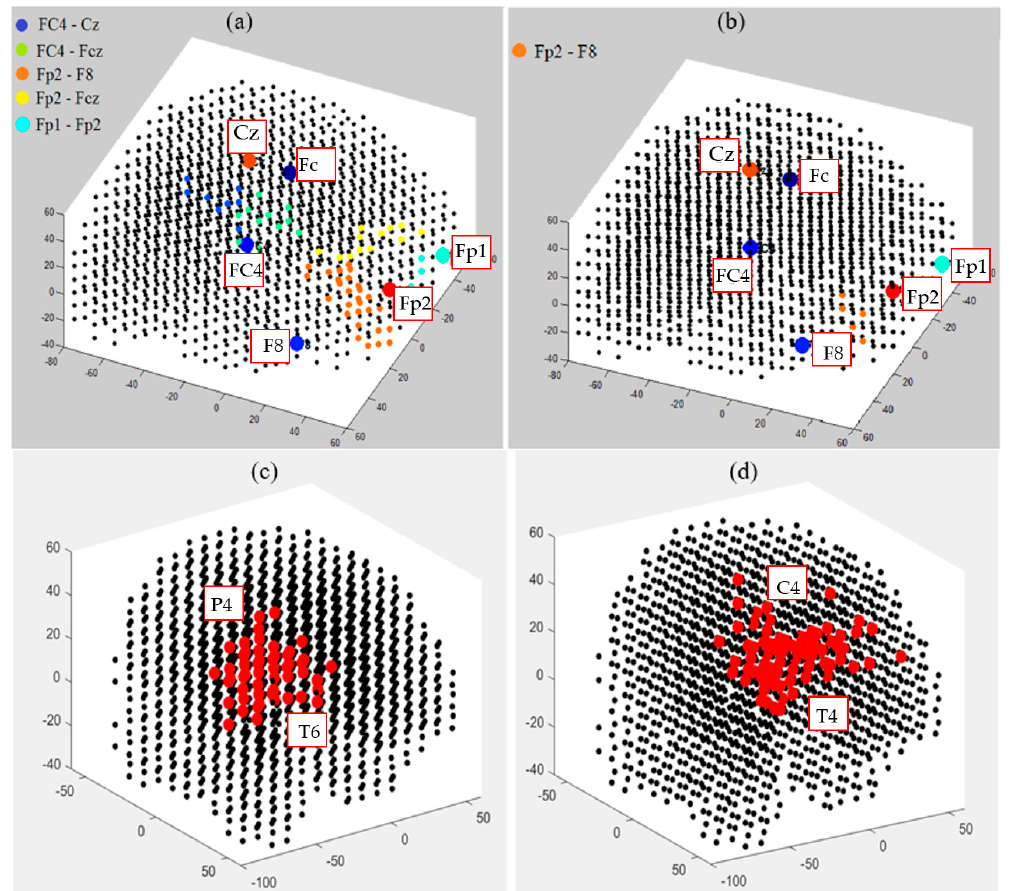
Figure 13. The fuzzy neural clusters (shared boundaries between clusters) captured after the unsupervised STDP learning in SNN models of ( a ) control group and ( b ) OP group. ( c , d ) The biggest fuzzy cluster in the control group has a size of 59 neurons, generated between P4 and T6 channels, while the biggest fuzzy cluster in OP group has a size of 70 neurons, generated between C4 and T4 channels.